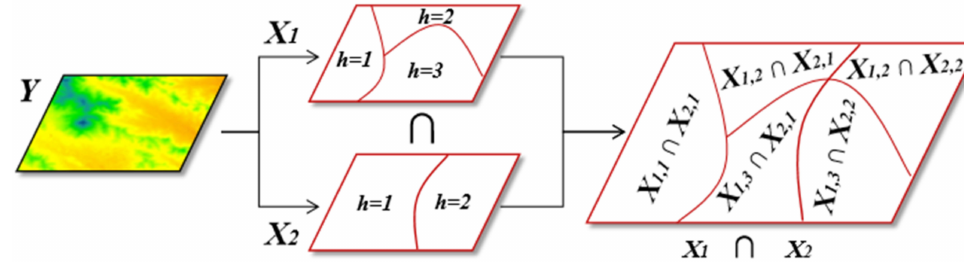
Figure 5. The detection of interaction. Table 3. The interaction